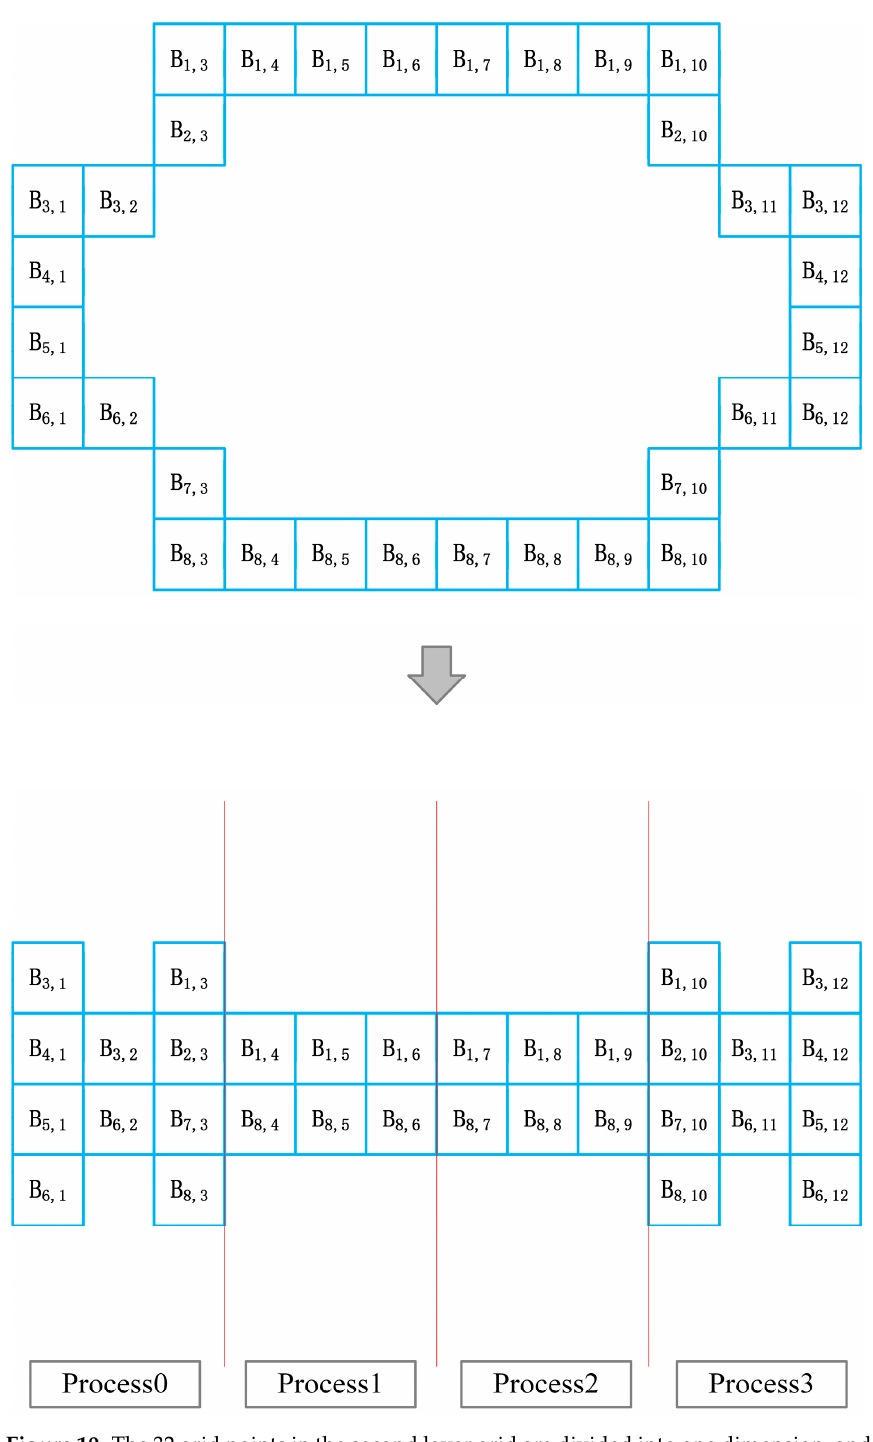
Figure 10. The 32 grid points in the second layer grid are divided into one dimension, and the number of grid points allocated to the 4 MPI processes are 10, 6, 6 and 10, respectively.